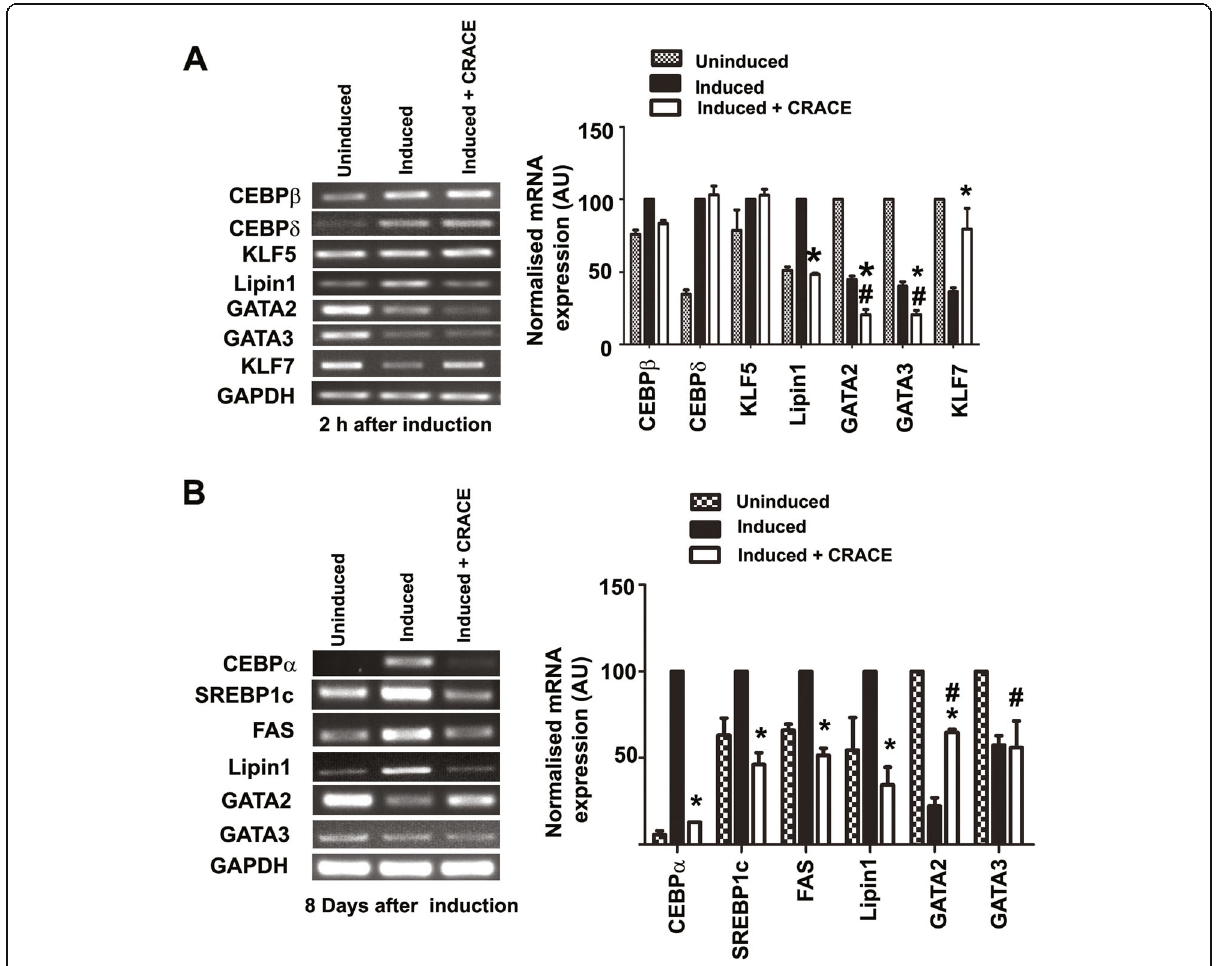
Fig. 2 CRACE modulated expression of pro- and anti-adipogenic regulators at early and late stage of adipogenesis. a . Gel images and bar diagram/diagrams represent RT-PCR analysis of early adipogenic regulators expressions in presence and absence of CRACE (500 μ g/mL equivalent); after 2 h of induction of adipogenesis in 3T3-L1 cells. b . Gel images and bar diagram represent RT-PCR analysis of adipogenic regulators expressions in presence and absence of CRACE (500 μ g/mL equivalent); at the late stage of adipogenesis (8 days post